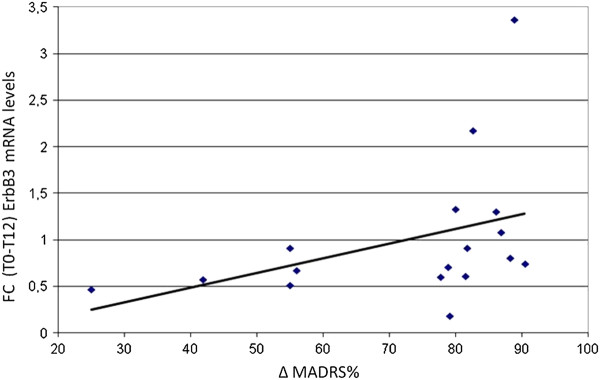
Correlation between percentage of symptoms improvement ΔMADRS% and Fold changes in ErbB3 mRNA expression (T0-T12). FC were calculated using the 2-ΔΔct method.